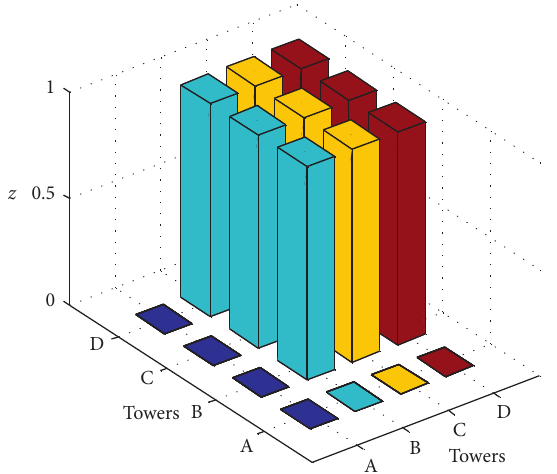
Figure 9: Assessment results of all tower and mast structures based on